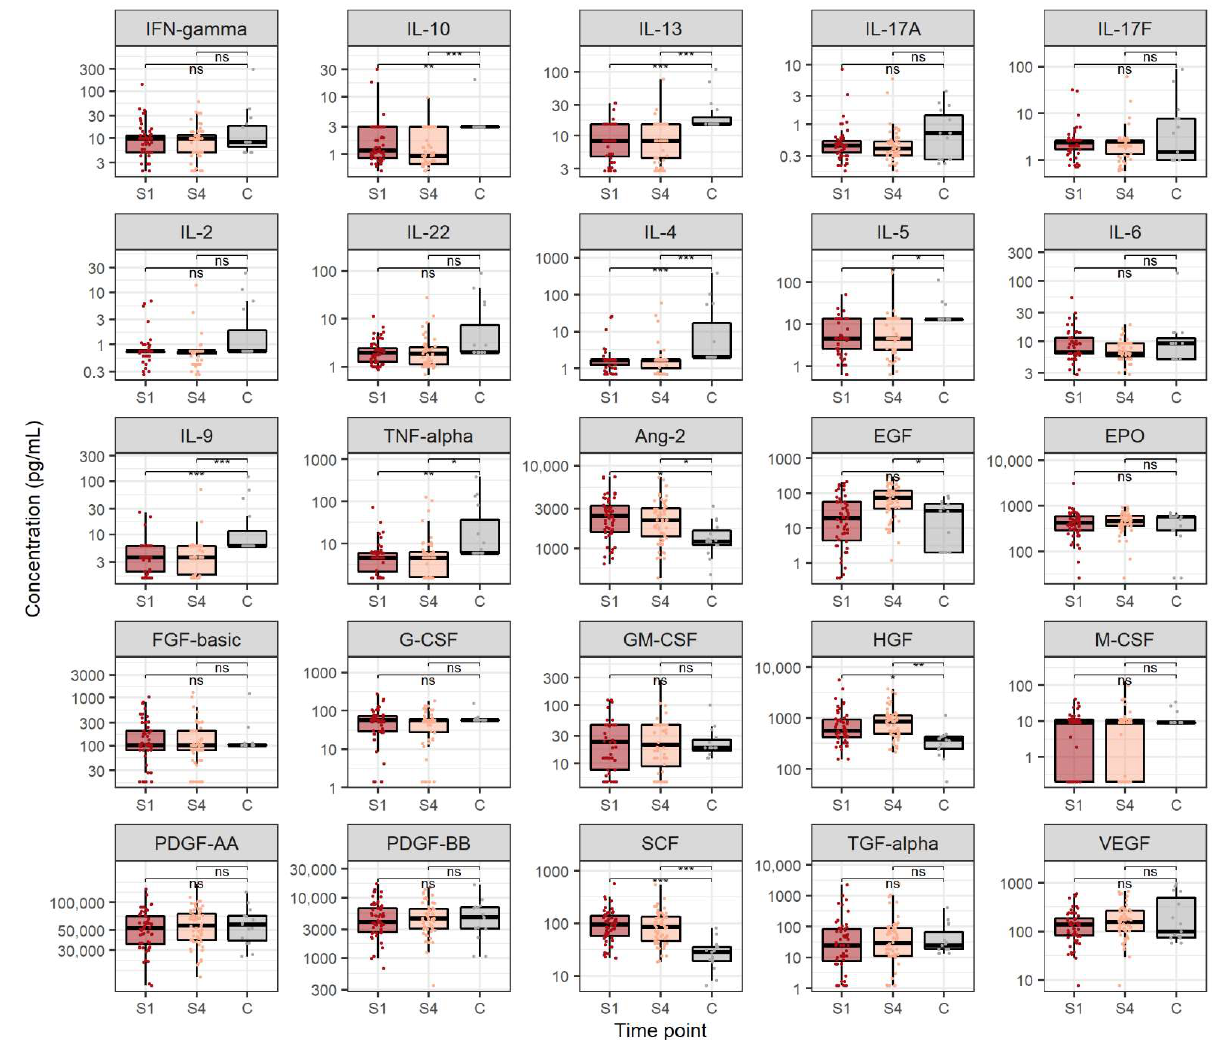
Figure 2. Cytokine and growth factor levels in chronic hepatitis C before antiviral treatment and after sustained virological response compared to healthy individuals. The boxes show the median and interquartile range of the distribution, whereas the whiskers extend to the minimum and maximum nonoutlier values of the distribution. Y -axis is logarithmically scaled. S1: before antiviral treatment, S4: sustained virological response, C: healthy control, ns: non-significant, *: p < 0.05, **: p < 0.01, ***: p < 0.001 (Mann–Whitney U test, p -values corrected with the Hommel method). Growth factors which displayed significantly higher levels in patients before start- ing antiviral treatment when compared to the control group were Ang-2 (medians 2454.0 and 1206.6 pg/mL, p = 0.018), HGF (medians 568.3 and 374.7 pg/mL, p = 0.041) and SCF (medians 96.4 and 28.6 pg/mL, p < 0.001). Likewise, growth factors which showed sig- nificantly higher levels in patients after reaching SVR when compared to the healthy in- dividuals were Ang-2 (medians 2180.4 and 1206.6 pg/mL, p = 0.027), EGF (medians 73.4 and 30.8 pg/mL, p = 0.037), HGF (medians 848.7 and 374.7 pg/mL, p = 0.006) and SCF (medians 86.5 and 28.6 pg/mL, p < 0.001). In order to assess the relative importance of cytokines and growth factors in CHC pathology, we used the random forest algorithm to classify the participants based on cytokine and growth factor levels measured before antiviral treatment in the patient and